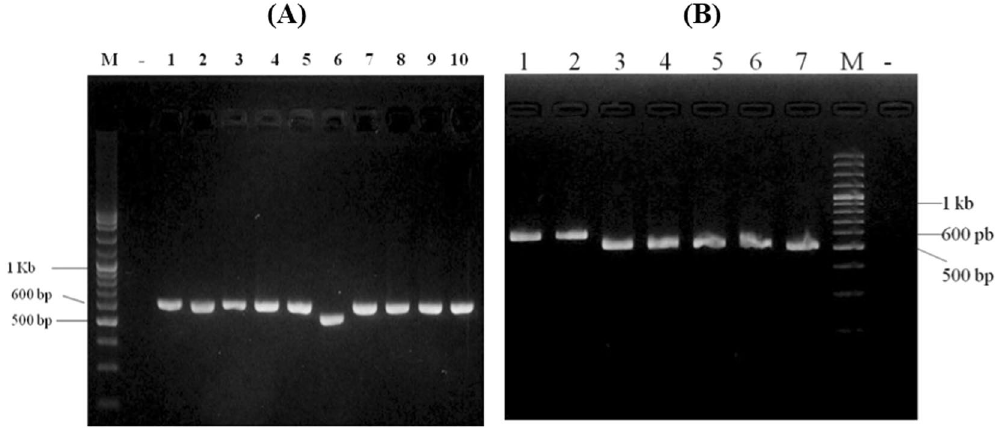
Figure 1. ( A ) The PCR fragment amplified using trnH-psbA primers. The smaller trnH-psbA PCR fragment was identified only in the Thao sample (lane no. 6) (M = 100 bp DNA marker, − = Negative control, 1–10 = longan samples). ( B ) The short trnH-psbA gene fragment amplified from 5 Thao longan cultivars compared with other longan samples. The deletion of trnH-psbA gene was detected in all of the Thao samples (lane 3–7) as compared with other longan cultivars (M = 100 bp DNA marker, − = Negative control, 1 = E-Daw, 2 = Lychee samples, 3–7 =